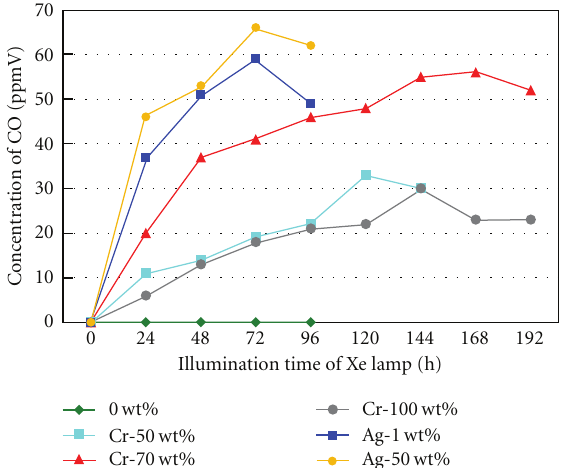
Figure 11: Comparison of produced concentration of CO among di ff erent R under the condition of illuminating Xe lamp without UV light.